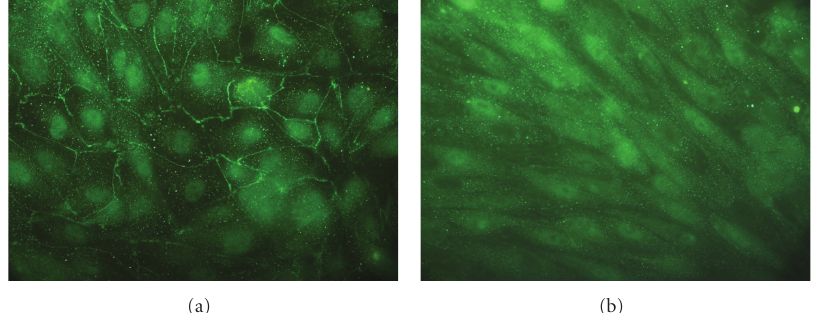
Figure 4: Immunofluorescent staining of EPOR in two cultures of hTECs that show an epoetin delta-induced e ff ect on oxidative stress (a) or not (b). EPOR signal is visualized using the M-20 anti-EPOR antibody and an FITC-labeled (green fluorescence) secondary antibody. Punctate intracellular staining is seen in both cultures while membranous staining is only seen in cultures that showed epoetin delta-induced e ff ects on oxidative